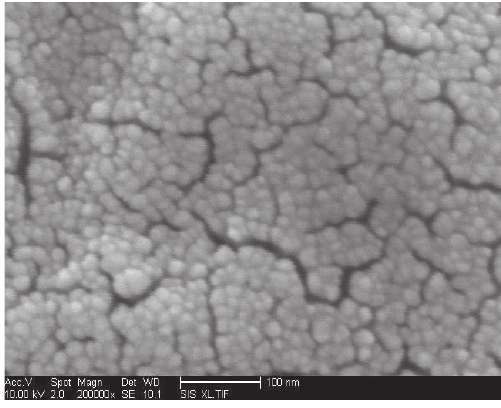
Figure 3: XRD patterns for TiO 2 composite film with MC: (a) heat treated at 100 ◦ C and (b) heat treated at 500 ◦ C.